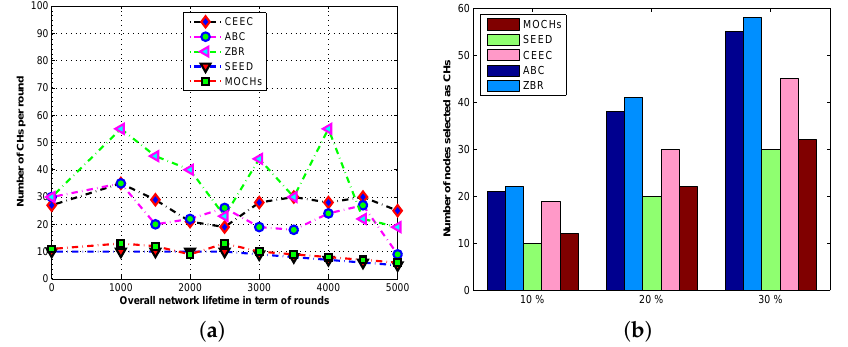
Figure 14. The comparison of total number of CHs selected per round in the lifetime of the network of MOCHs with different protocols. ( a ) The analysis of number of CHs per in the network; ( b ) The effect of different of number of CHs on the network.